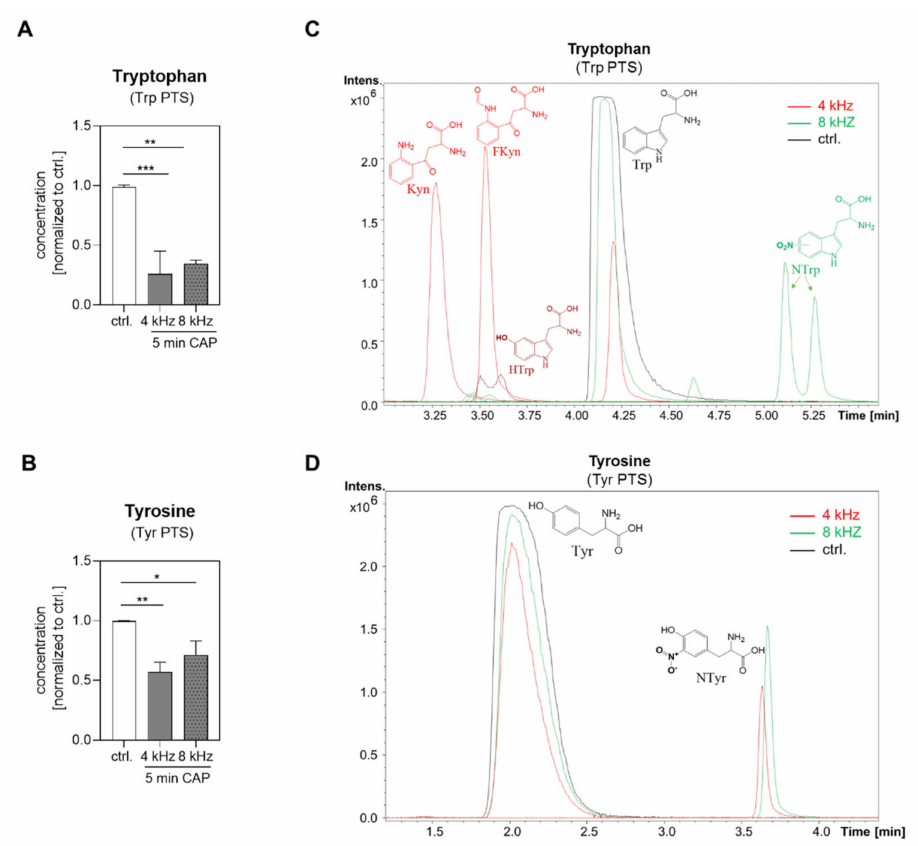
Figure 4. Amino acid modifications in Trp and Tyr PTS. Quantification of the amino acids Trp ( A ) and Tyr ( B ) in Tyr and Trp solution [1 mM in water bidest.] by NMR spectroscopy before CAP treatment (control) and after 5 min of 4 kHz and 8 kHz CAP treatment (n = 3 per solution). The ( C ) HPLC-TOFMS measurements identified HTrp, FKyn, Kyn and NTrp in the Trp PTS, and ( D ) NTyr in the Tyr PTS. All of the compounds were tentatively identified. Statistical analysis: Bonferroni’s multiple comparisons test. * p < 0.05, ** p < 0.01, *** p < 0.001 (4 kHz, 8 kHz versus